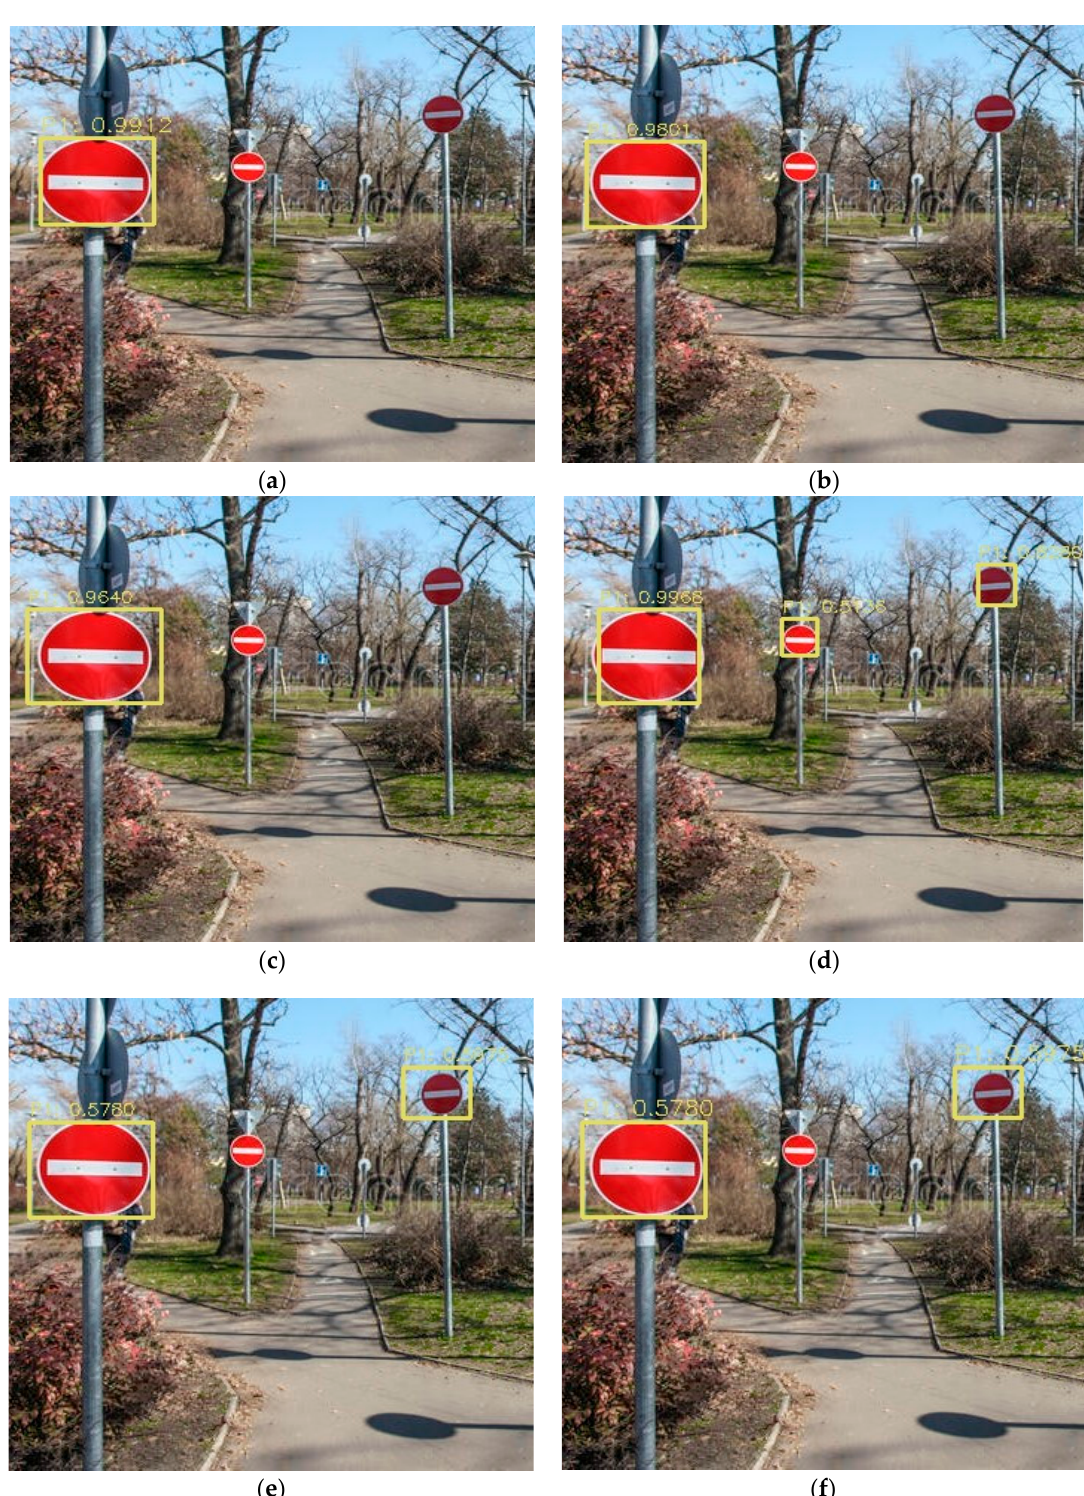
Figure 6. Recognition test for prohibitory sign class P1 by ( a ) Yolo V3 1, ( b ) Yolo V3 2, ( c ) Yolo V3 3, ( d ) Yolo V3 SPP 1, ( e ) Yolo V3 SPP 2, and ( f ) Yolo V3 SPP 3.